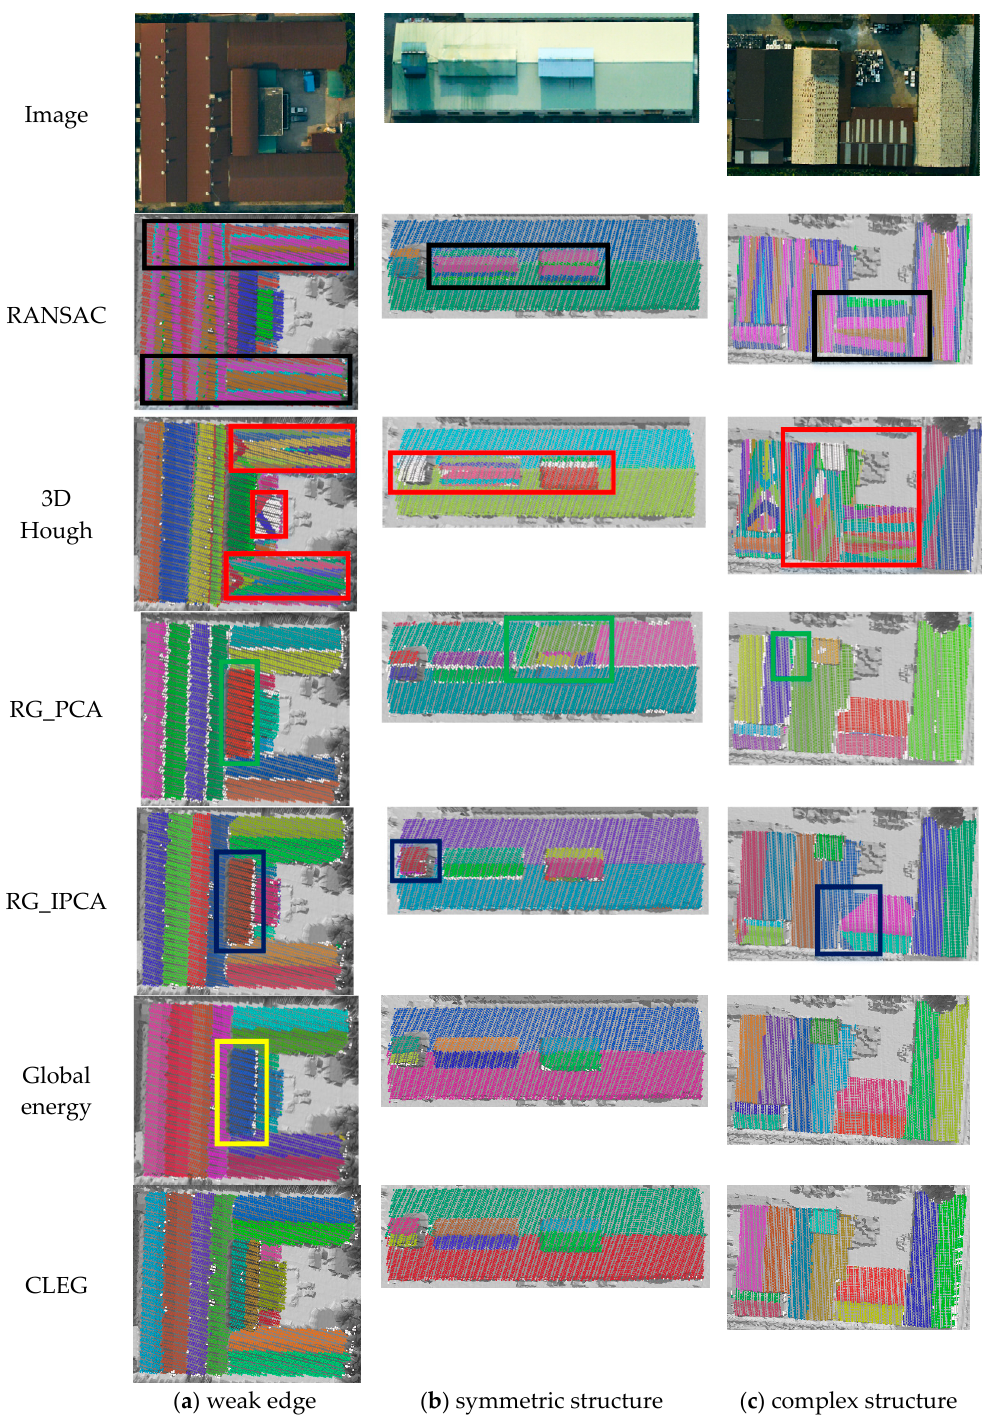
Figure 10. Segmentation of roof points in the Guangzhou area. ( a ) weak edge; ( b ) symmetric structure; ( c ) complex structure.